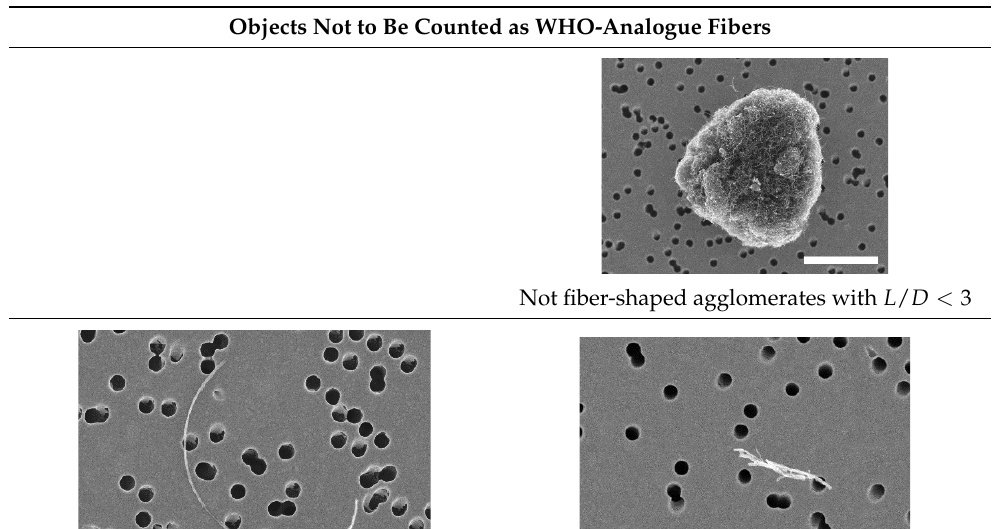
Table 5. Categories for categorizing respirable particles according to morphology, exemplified by example images. The length of the scale bar is 2 µm .